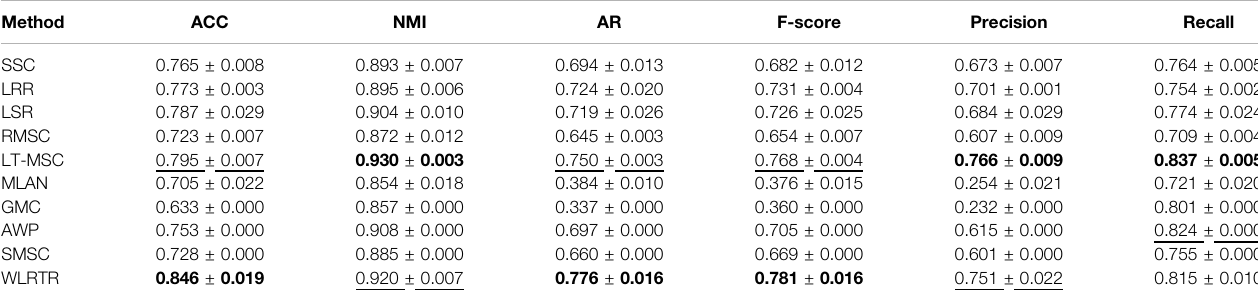
TABLE 2 | Clustering results on ORL